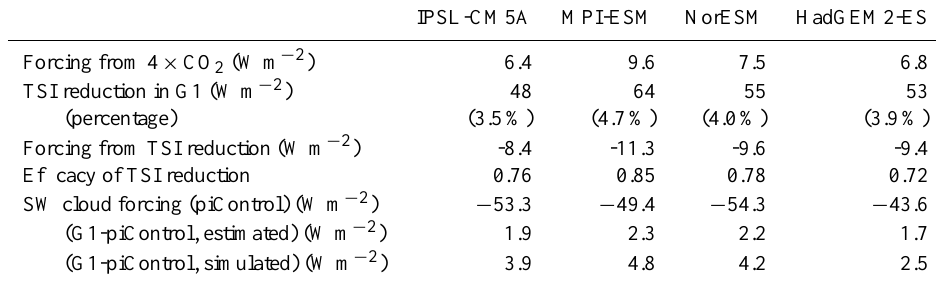
Table 2. Comparison of TOA forcings from quadrupling CO 2 , total solar irradiance (TSI) reduction, and